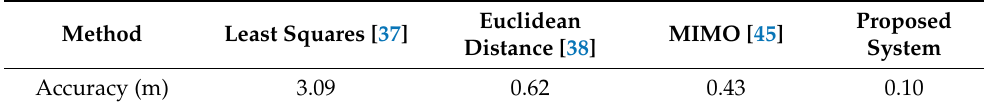
Table 2. Positioning accuracies of positioning